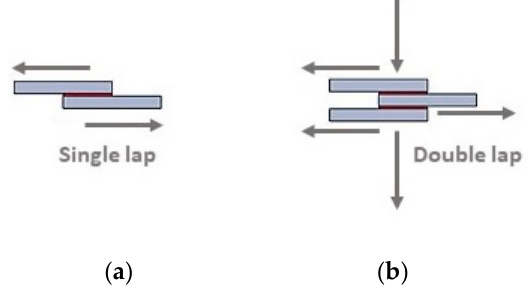
Figure 16. Single ( a ) and double ( b ) lap shear test